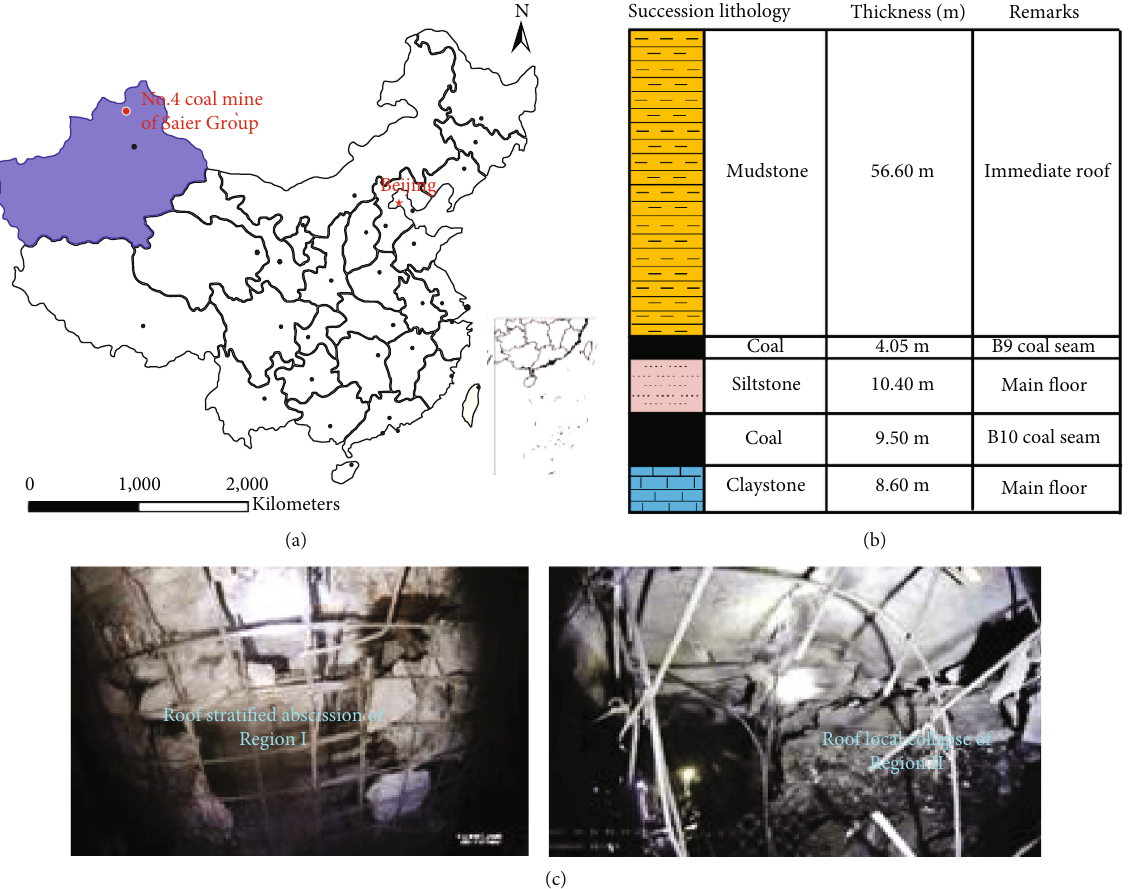
Figure 1: Location map (a), histogram of the strata (b), and fracture photos (c) of roadway